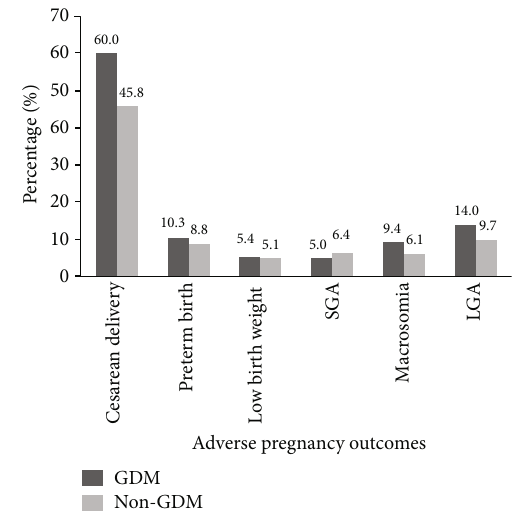
Figure 1: Percentage of adverse pregnancy outcomes by gestational diabetes mellitus. Abbreviations: GDM: gestational diabetes mellitus; SGA: small for gestational age; LGA: large for gestational